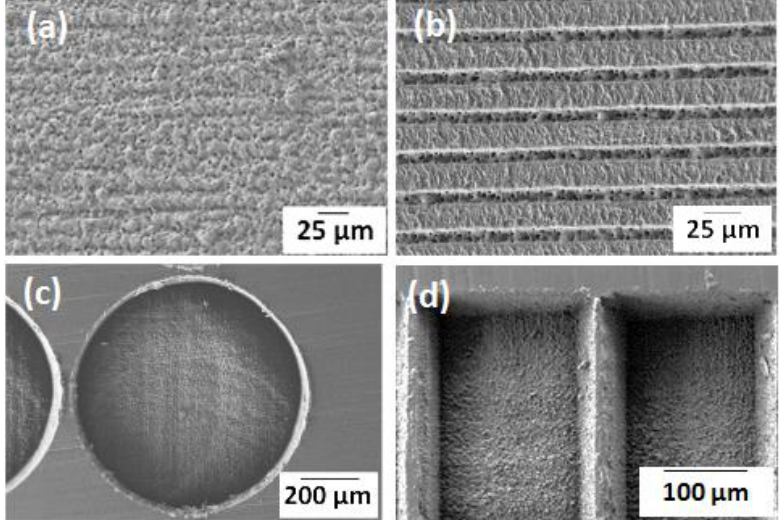
Figure 1. SEM images of laser-treated PLLA: laser-irradiated ( “rough”) PLLA ; ( a ) grooves with 10 μm width, 4 μm depth, and 15 μm spacing ; ( b )circular; ( c ) and rectangular; ( d )